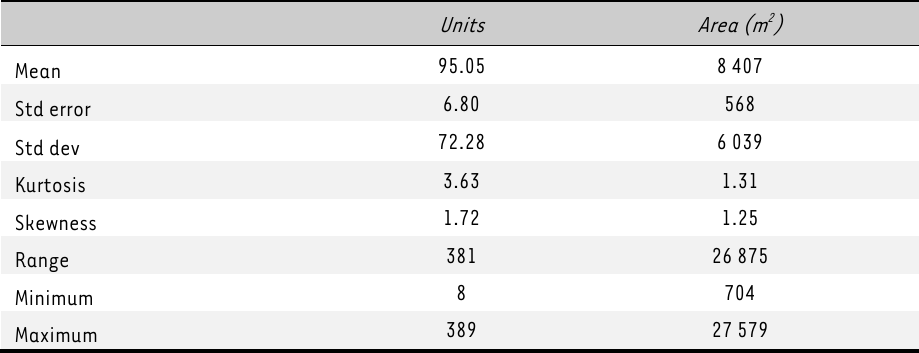
TABLE 2: Descriptive statistics of the number of units and area of STDSs (n = 113)